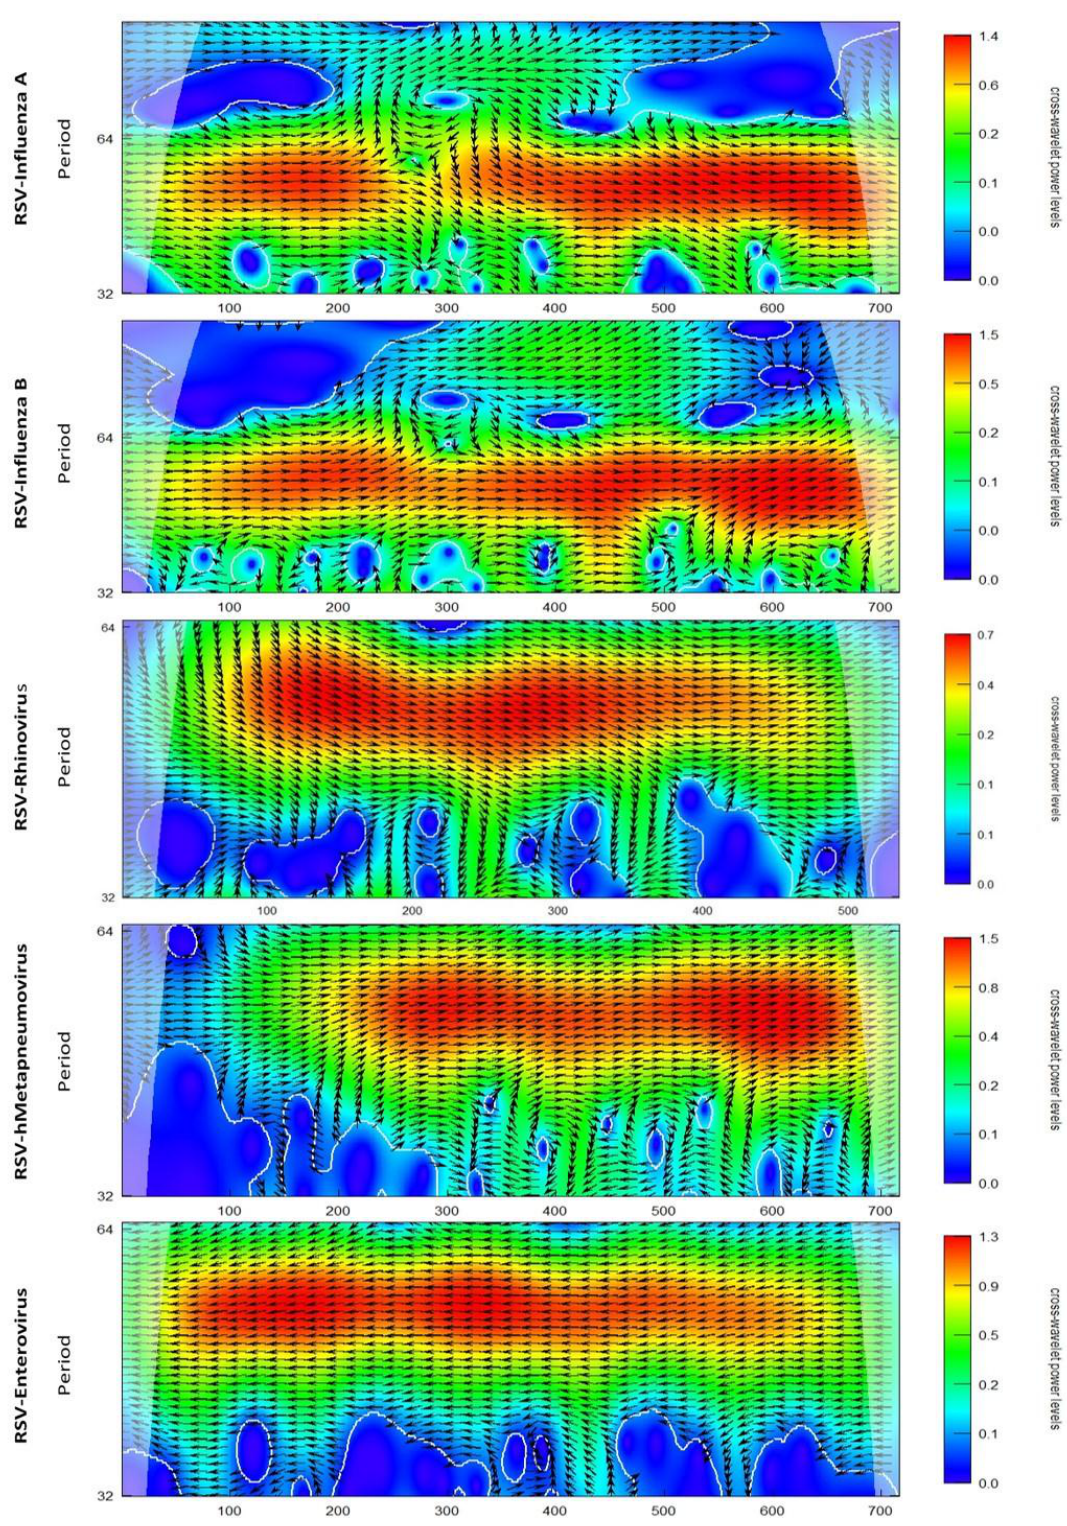
Figure A4. Cross-wavelet power spectrum.